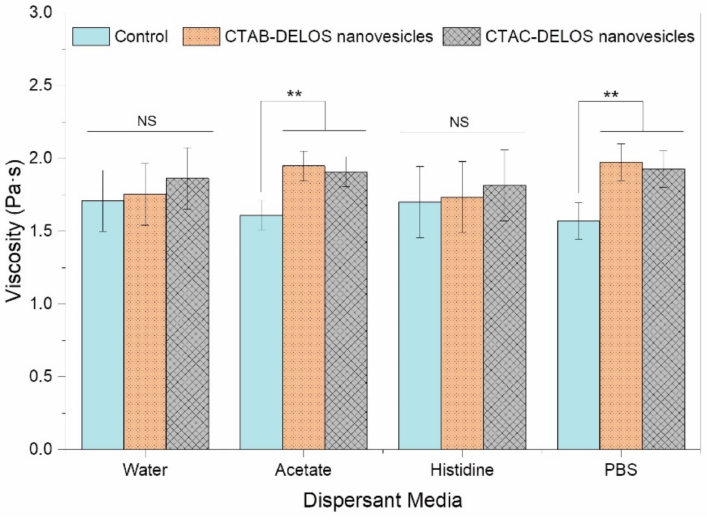
Figure 5. Viscosity measurements of the evaluated Methocel TM K4M hydrogels, controls (samples without the nanovesicles) and DELOS nanovesicles-based hydrogels using CTAB- (orange, points) or CTAC-DELOS (grey, squares) nanovesicles in water, acetate, histidine, and PBS ( N = 3). Data plotted as mean viscosity are represented by the heights of bars with 95% confidence intervals represented by the error bars. Statistical analyses were performed by one-way ANOVA followed by Tukey pairwise comparison. ** p < 0.01 and NS: non-significant